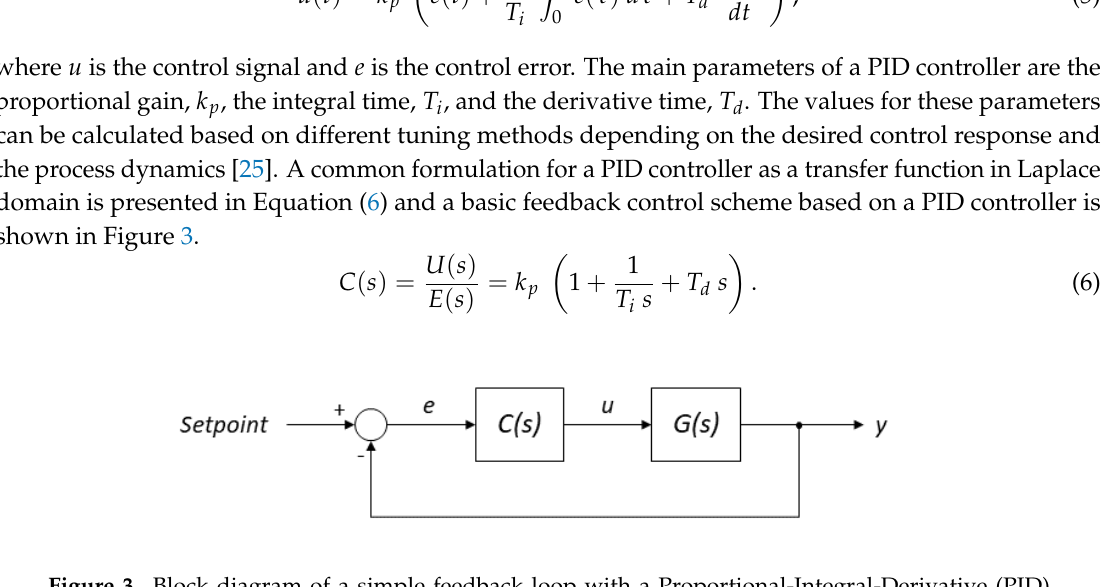
Figure 3. Block diagram of a simple feedback loop with a Proportional-Integral-Derivative (PID) controller, C ( s ) , applied to a process represented with a transfer function, G ( s )